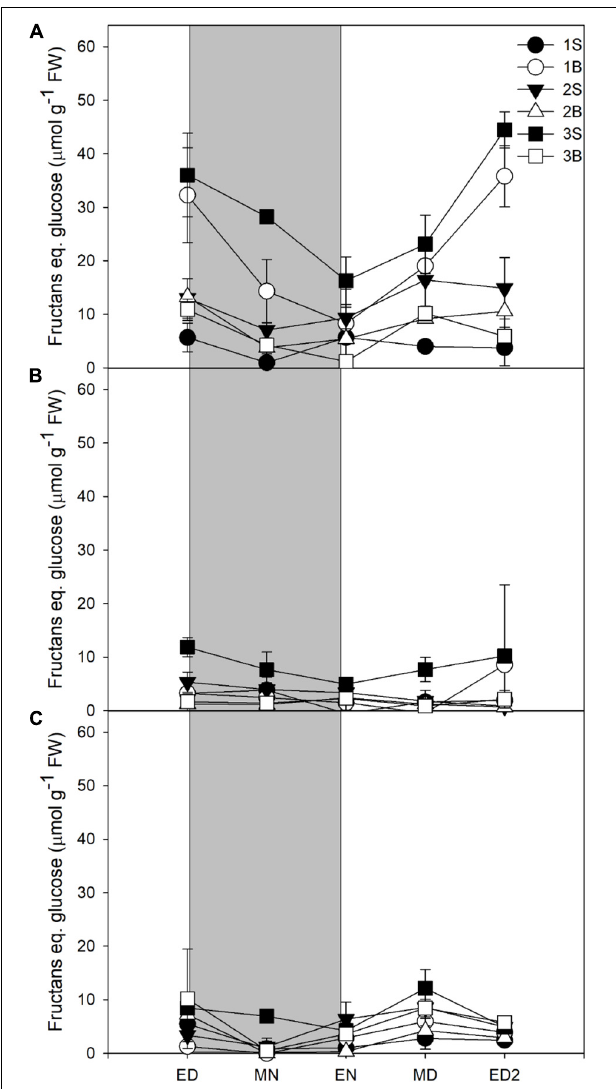
FIGURE 3 | Diurnal fructans levels of barley cv. Propino plants grown under three light intensities. Fructans levels of plants grown for (A) 14 DAS under 500 µ mol photons m − 2 s − 1 (HL), (B) 16 DAS under 300 µ mol photons m − 2 s − 1 (ML) and (C) 18 DAS under 100 µ mol photons m − 2 s − 1 (LL), until third leaf stage. Plants were grown in a 16 h:8 h light:dark photoperiod 22 ◦ C:18 ◦ C day:night. 1S: 1st leaf sheath; 1B: 1st leaf blade; 2S: 2nd leaf sheath; 2B: 2nd leaf blade; 3S: 3rd leaf sheath; 3B: 3rd leaf blade; ED: end of day; MN: middle of night; ED: end of night; MD: middle of day; ED2: end of subsequent day; FW: fresh weight; gray panels: night period; error bar represents SD; n = 3. Statistical analyses were performed to assess differences between time points, tissues and light treatments by ANOVA with Tukey’s post hoc test P < 0.05, and results are available in Supplementary Table 1 .